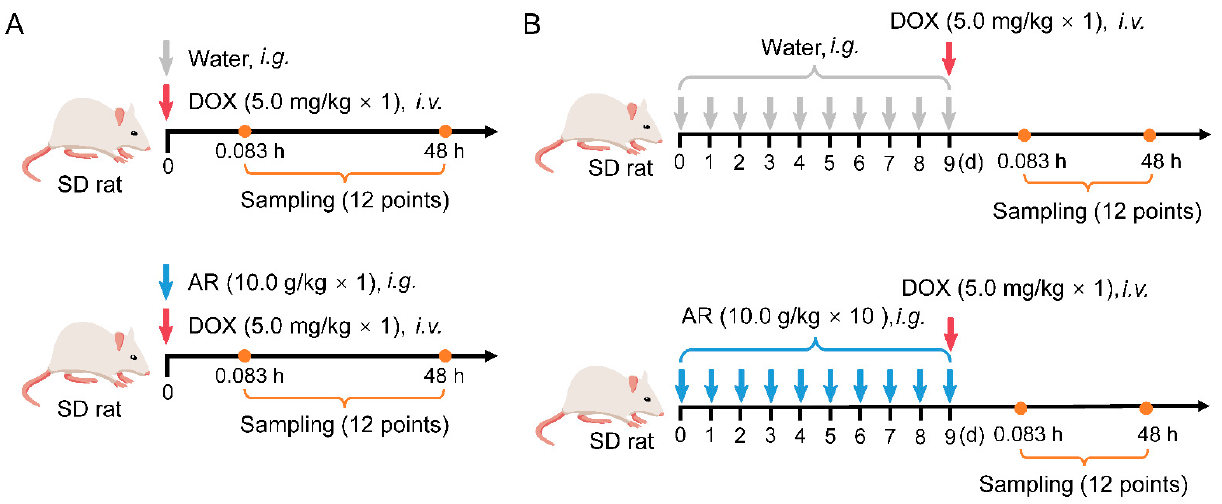
Figure 1. Schematic of animal experiments. (A) Mice received 5.0 mg/kg DOX via the tail vein after a single dose of 10 g/kg AR administration. (B) Mice received 5.0 mg/kg DOX via the tail vein after 10 days pre-treatment with AR (10 g/kg/d). DOX: doxorubicin, AR: Astragali Radix. Table 3. The pharmacokinetic parameters after intravenous administration of 5 mg/kg doxorubicin (DOX) following the treatment with Astragali Radix (AR) (mean ±